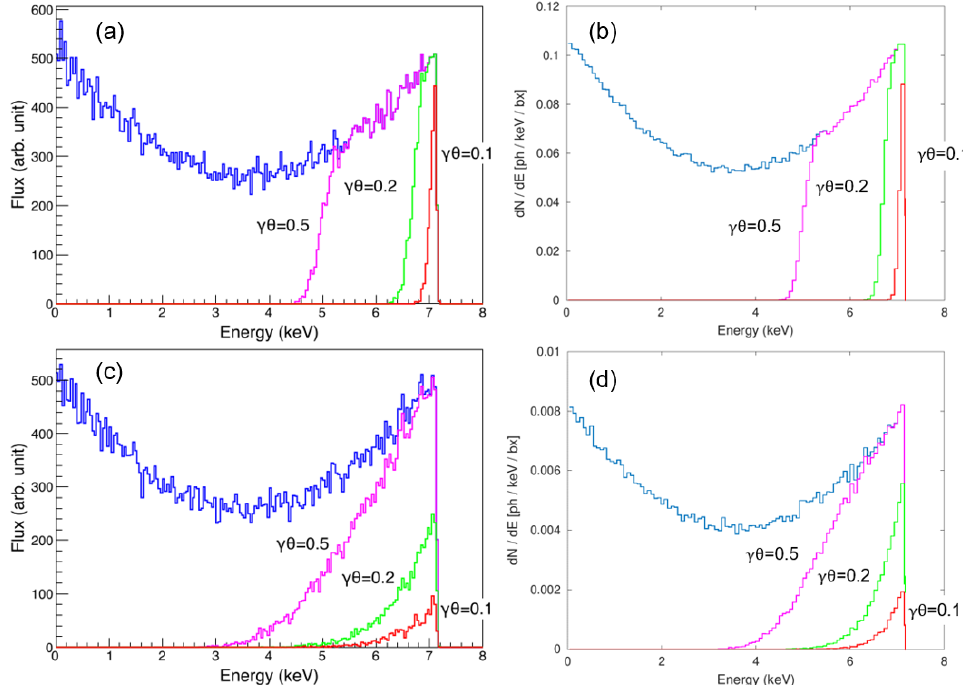
Figure 7. Comparison of cERL photon spectra computed in CAIN and RF-Track for different values of emittance. CAIN photon spectra at ( a ) (cid:101) N = 1mmmrad and ( c ) (cid:101) N = 5mmmrad. RF-Track photon spectra at ( b ) (cid:101) N = 1mmmrad and ( d ) (cid:101) N = 5mmmrad. Figures for three distinct collection angles were shown, along with the full energy